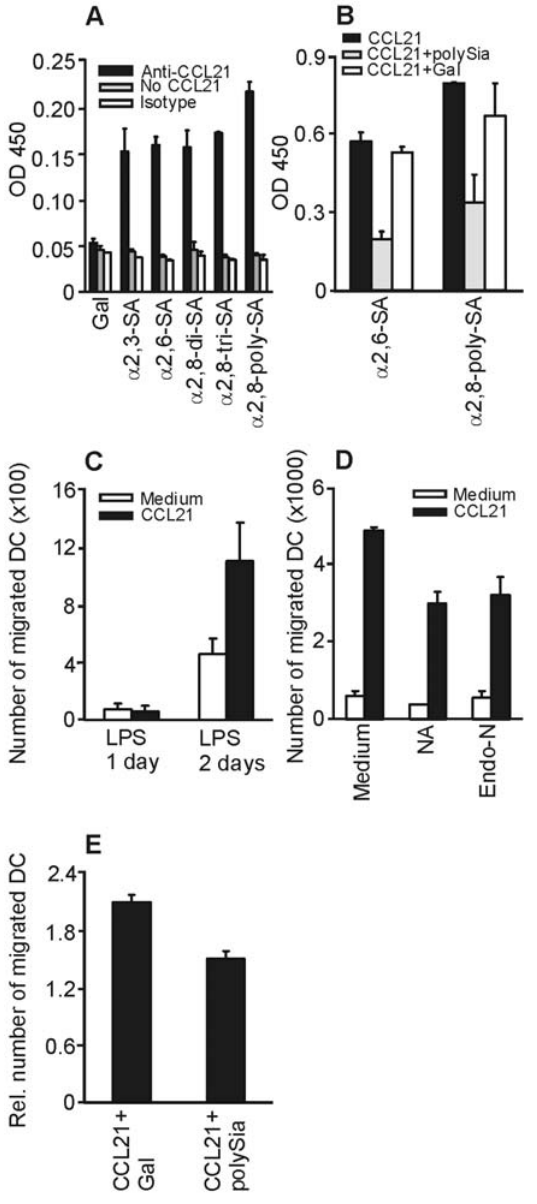
Figure 2. CCL21 binding to sialic acid is required for CCL21- directed migration of DCs. (A) CCL21 binding to coated PAA- conjugated glycans was analyzed by anti-CCL21 antibody and peroxidated goat anti-mouse antibody binding. As a control, CCL21 was substituted by PBS (grey bar) or a murine IgG1 isotype control (white bar) (N=4). (B) Binding of CCL21 pre-incubated with PBS (black bar), PAA-conjugated polySia (grey bar) or PAA-conjugated galactose (white bar) to coated PAA-conjugated a 2,6-linked sialic acid or a 2,8- linked polySia. CCL21 binding was analyzed by anti-CCL21 antibody and peroxidated goat anti-mouse (N=2). (C) DC migration to CCL21 was measured in a transwell assay. Depicted are the numbers of migrated DCs matured for 1 day with LPS (not expressing polySia) or for 2 days with LPS (expressing polySia) to medium (white bar) or medium supplemented with CCL21 (black bar) (N=4). (D) Migration of mDCs (2 days LPS) treated with NA or Endo-N to medium (white bar) or medium supplemented with CCL21 (black bar) (N=4). (E) Migration of mDCs (2 days LPS) to CCL21 in the presence of soluble galactose or a 2,8-linked polySia (N=4). Depicted is the relative migration of mDCs towards CCL21 compared to medium controls.